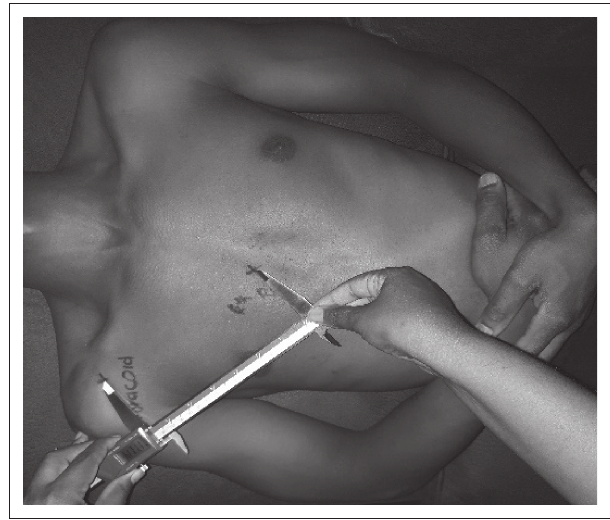
FIG URE 2: Measurements using a Vernier®